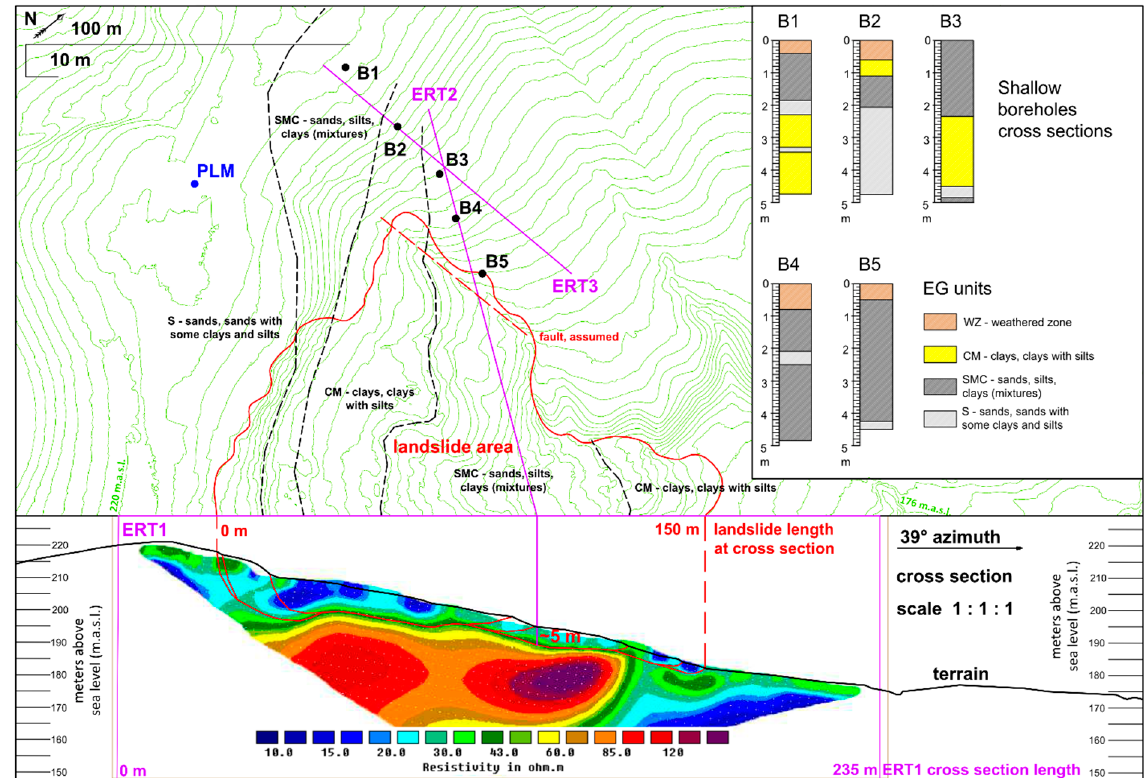
Figure 5. Sliding surfaces depth interpretation at ERT1 and borehole data (B1–B5).